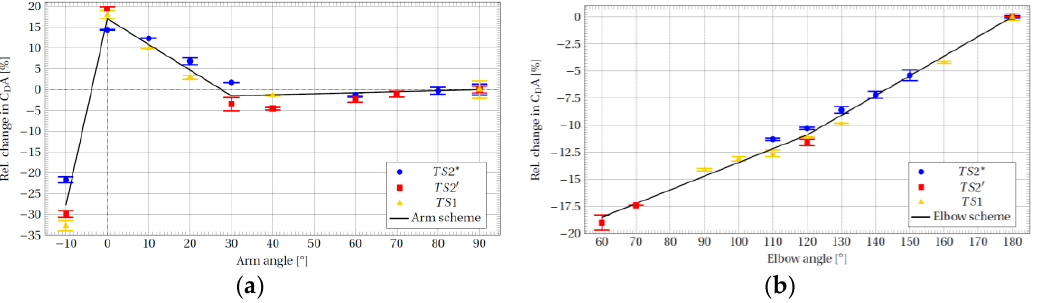
Figure 4. Percentage change of C D A values, relative to the reference position. TS2* represents measurements from the reference position of test subject 2 (TS2), TS2’ represents measurements done with a high knee angle and a low hip angle on TS2, TS1 is a preliminary experiment in the lowest position for the test subject. For the arm angle − 10° is defined as arms in front of the body.